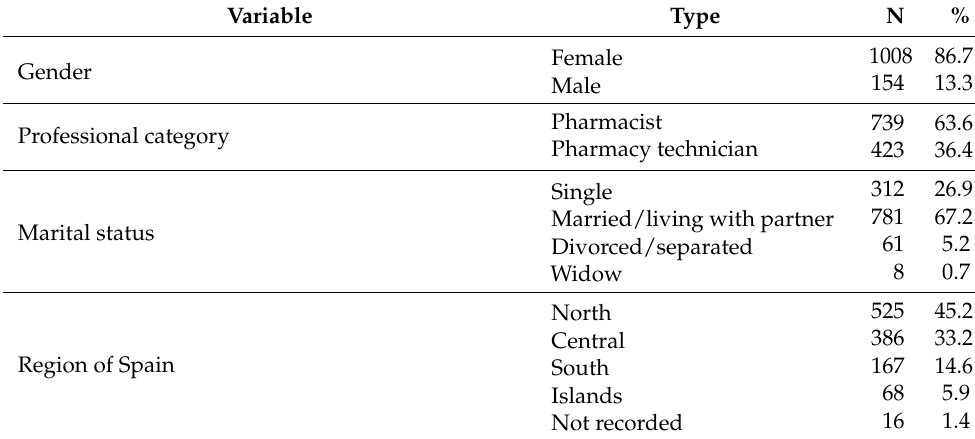
Table 1. Participants’